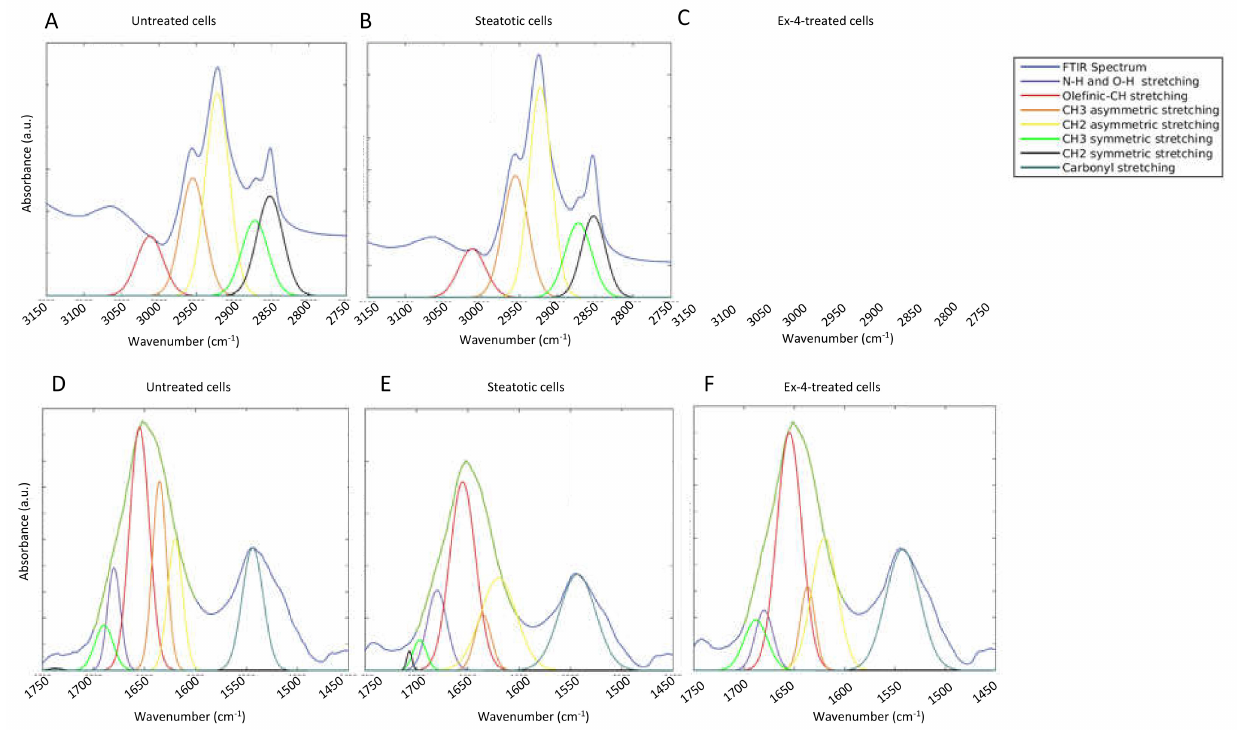
Figure 3. Curve fitting of the FTIR spectra. ( A – C ) Curve fitting of the lipid region in the mean FTIR spectra of the untreated cells, steatotic cells, and steatotic cells treated with Exendin-4. ( D – F ) Curve fitting of amide I and II regions in the mean FTIR spectra of the untreated cells, steatotic cells, and steatotic cells treated with Exendin-4. The overlapping hidden peaks were identified and reconstructed by performing peak fitting on the spectra. The amide I band (1700–1600 cm − 1 ) arises mainly from the backbone C=O stretching vibrations (~80%) of the amide groups coupled with little in-plane NH bending (< 20%) [62], while the amide II band results from backbone N-H bending and C-N stretching vibrations in the spectral range of 1580–1510 cm − 1 [63]. The most critical and frequent band used to explain the secondary structure of polypeptides is the amide I band, as the amide II and amide III bands have multiple assignment contributions